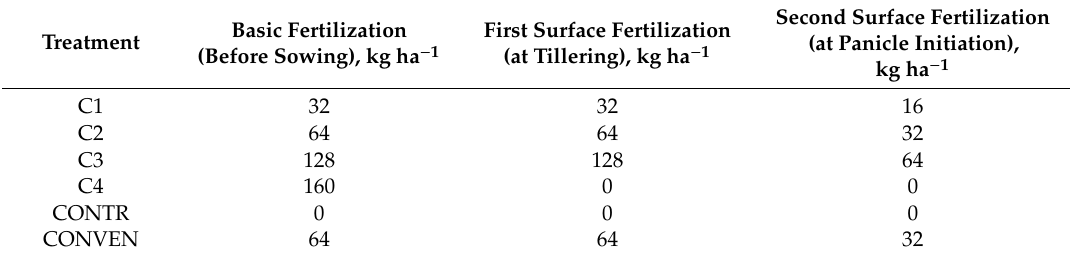
Table 3. Di ff erent fertilization treatments, their abbreviations, and the amount of nitrogen units (kg ha − 1 ) were used at di ff erent stages during the rice-growing season (before sowing, at tillering, and at panicle